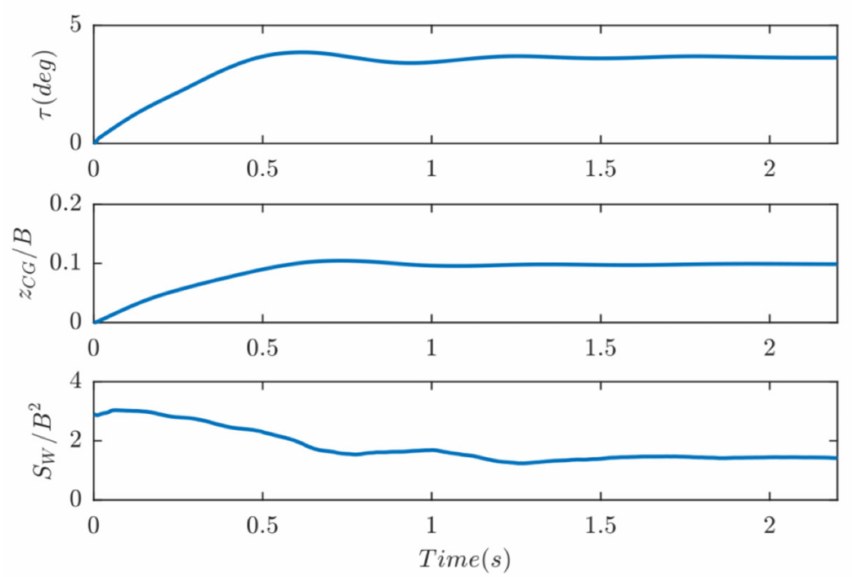
Figure 7. A sample of convergence of all parameters, showing how a CFD model calculates the equilibrium condition for the deep-V hull operating in planing mode at speed of 7 m/s (corresponding to the beam Froude Number of 1.48) for morphing turbulent simulation. Upper, middle and lower panels respectively refers to data corresponding to convergence of trim angle, C.G rise up and wetted surface.